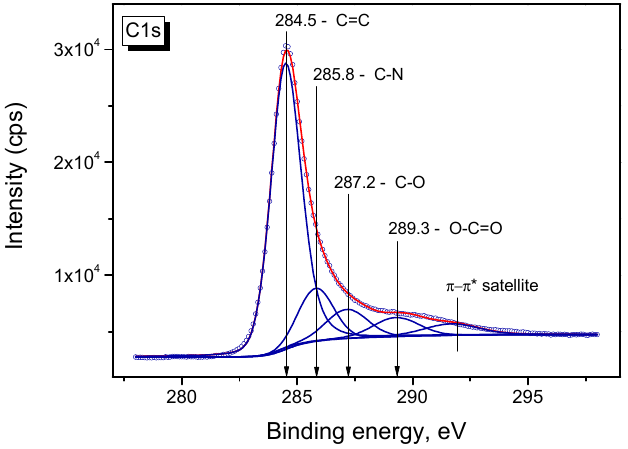
Figure 5. C1s XPS spectrum of fresh 0.4% Pt/N-graphene catalyst.